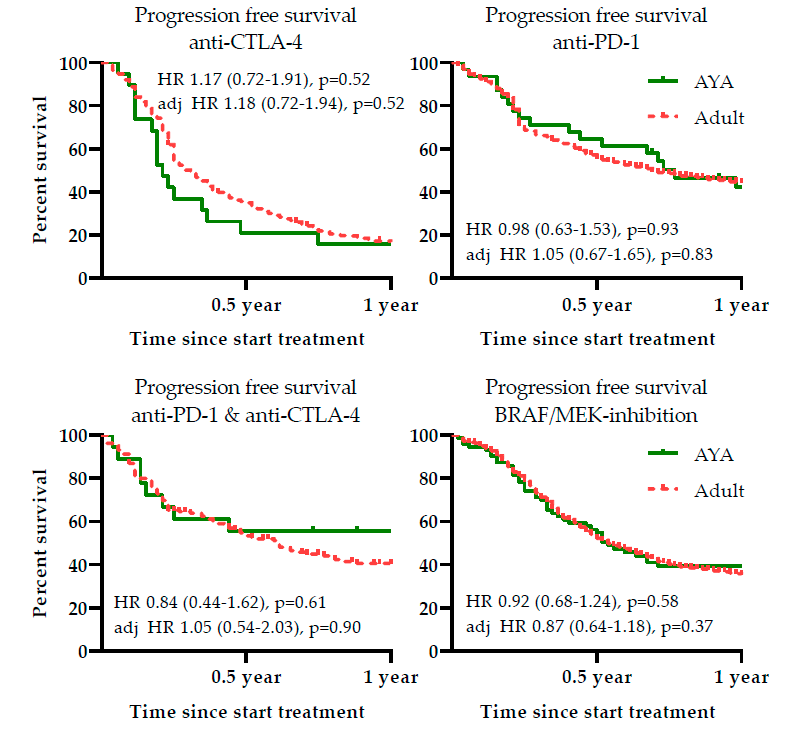
Figure 5. Progression free survival following first-line systemic therapy in Adolescents and Young Adults (AYAs) and older adult (Adult) patients. Hazard ratio (HR) for progression is provided, along with the adjusted HR (adjusted for: lactate dehydrogenase level, Eastern Cooperative Oncology Group performance status, distant metastasis in ≥ 3 organ sites, the presence of brain metastases and the presence of a BRAF V600 mutation).